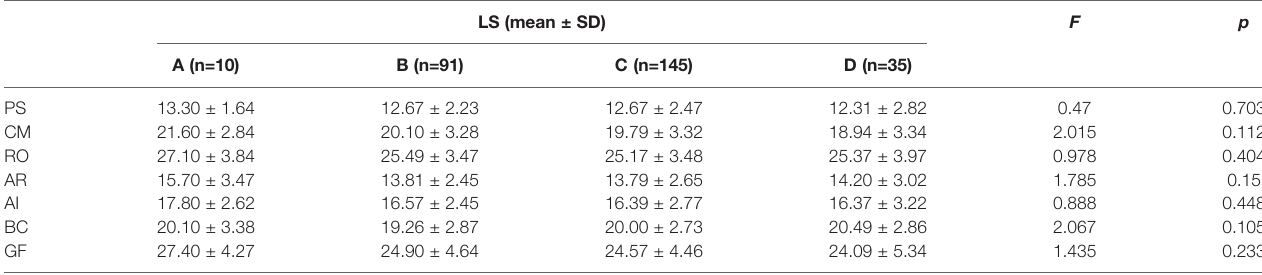
TABLE 4 | Comparative analysis of family function based on different living